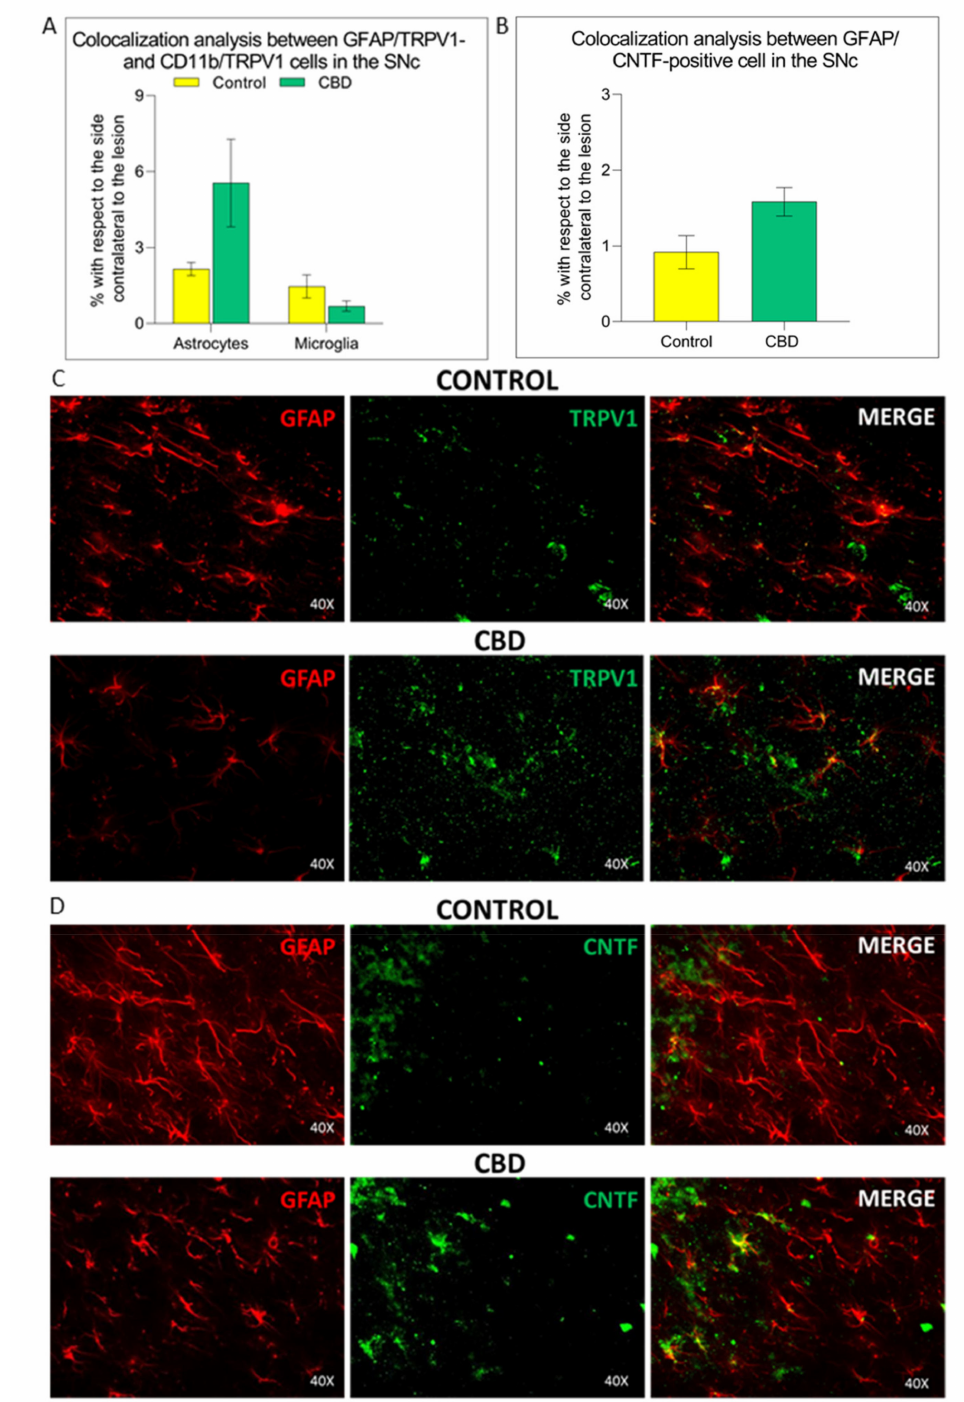
Figure 6. TRPV1 and CNTF glial expression in the substantia nigra. ( A ) Quantification of TRPV1 expression in astrocytes and mi-croglia. ( B ) Quantification of CNTF expression in astrocytes. ( C , D ) Representative images of the TRPV1 and CNTF expression in both glial subpopulations in the SNc, in both experimental groups. The results are expressed as mean ± SEM. N = 4 to 5 in each